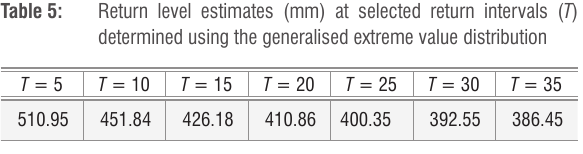
Return level estimates (mm) at selected return intervals ( T )